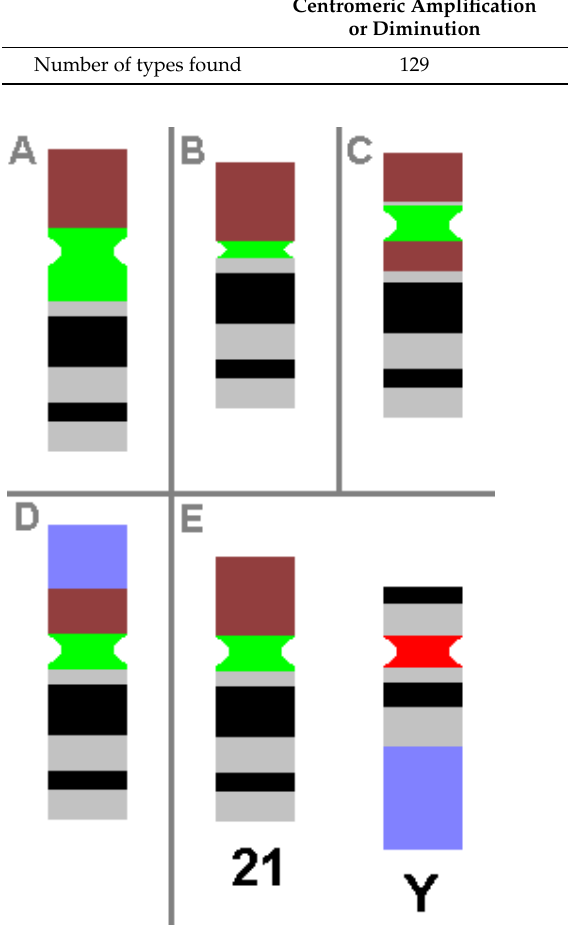
Figure 1. Schematic depiction of CHs, as known from cytogenetic diagnostics. Possible examples of centromeric amplification ( A ), centromeric diminution ( B ), pericentric inversion ( C ) and translocation ( D ) in chromosome 21 are shown, compared to a ‘normal’ chromosome 21 and a normal Y ‐ chromosome ( E ). For clarity, the short arm of chromosome 21 is depicted in brown, the centromeric regions of chromosome 21 and Y ‐ chromosome are in green and red, respectively, and the heterochromatic region of the Y ‐ chromosome in the long arm is in blue. All aberrations shown do not cause any clinical problems.